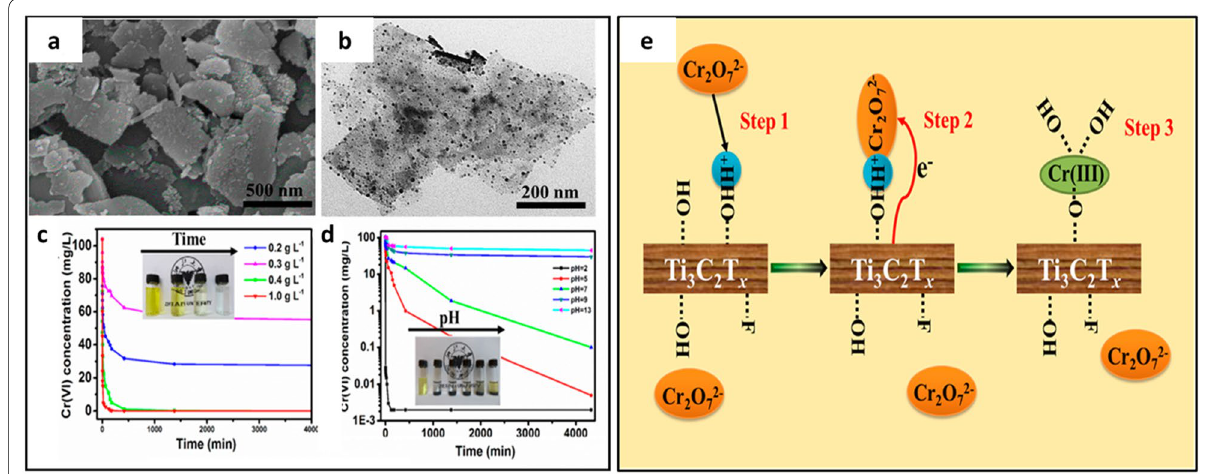
Fig. 3 a SEM, b TEM, c dosage effect of the Ti 3 C 2 T x on Cr (VI) removal with insert showing corresponding photo with change in color visible in in the case of 0.4 g; d Influence of pH on the Cr (VI) removal efficiency of MXenes; e schematic of the charge-interaction based mechanism for the removal of Cr(VI) using Ti 3 C 2 T x nanosheets. Reprint with permission [26]: copyright 2015, American Chemical